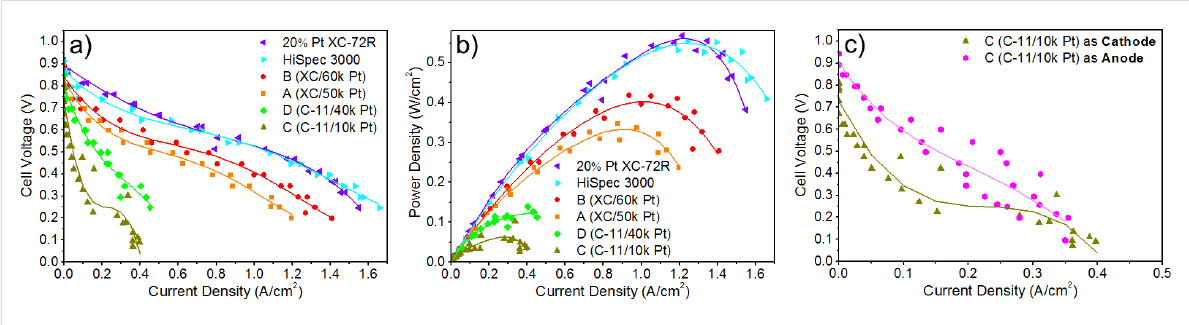
Figure 7: The results of the tests performed in PEMFCs supplied with H 2 /air: (a) steady-state polarization curves for the materials being tested as a cell cathode, (b) steady-state power density curves for the materials being tested as a cell cathode, and (c) steady-state polarization curves for materi- al C being tested as a cell cathode and anode. The temperature of cell and humidifier was 80 °C, the backpressure at cathode and anode was 2.0 bar. The cathode was fed with air at 500 std cm 3 /min, and the anode was fed with H 2 at 100 std cm 3 /min.